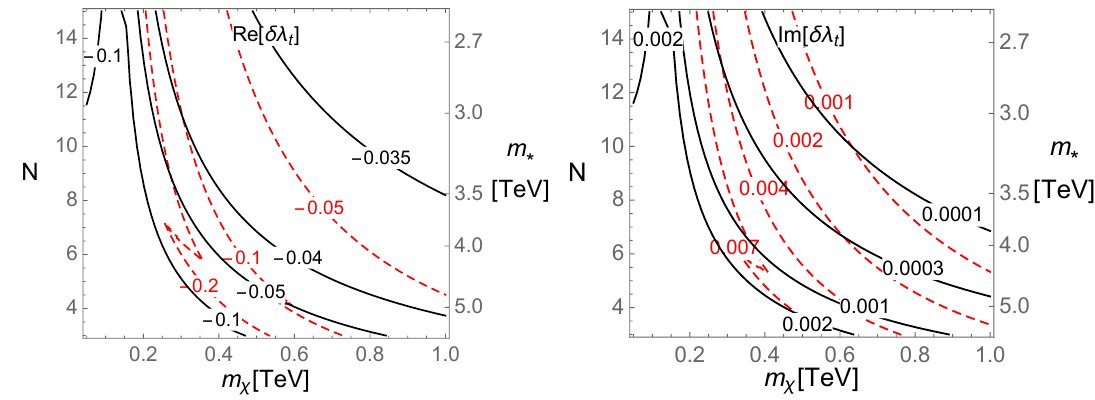
Figure 14 . Real (left panel) and imaginary (right panel) parts of the top Yukawa modi(cid:12)cation in the benchmark model with a varying top mixing for a meson-like dilaton (red dashed) and a glueball-like dilaton (black solid). The real part can be tested by CLIC at the 4% level at 1 (cid:27) [68], and a pure composite Higgs contribution to it (with no Higgs-dilaton mixing) is -0.05. For the tests of the imaginary part see